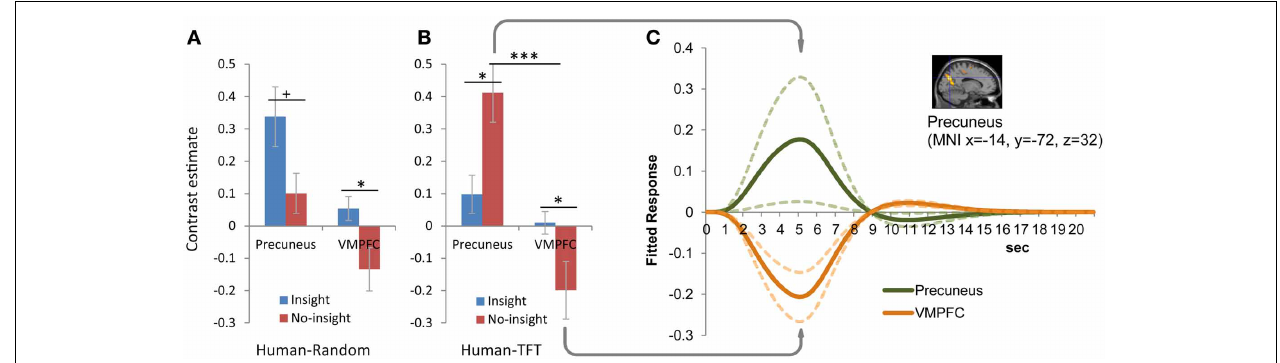
FIGURE 4 | Differential activation in the precuneus and VMPFC between those with and without insight into reciprocity of human partners. (A) Human-random (HR) session. (B) Human-tit-for-tat (HT) session. Insight into reciprocity interacted with partner strategy in activation in the precuneus [( − 14, − 72, 32), FWE corrected p < 0 . 01], but was associated specifically with activation in the VMPFC [( − 10, 32, − 4), FWE-corrected p < 0 . 05]. The reverse association of activation with the presence and absence of insight [(Insight/No-Insight) × (precuneus/VMPFC);